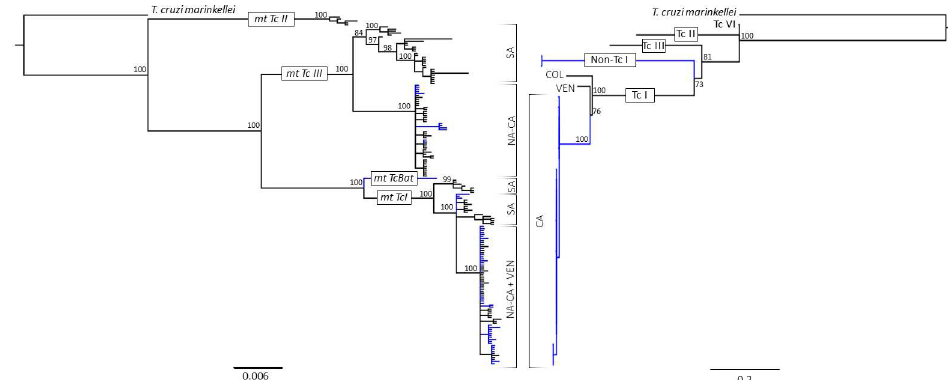
Fig 2. Trypanosoma cruzi phylogenetic analysis based on mitochondrial DNA and nuclear single copy genes. Left: Mitochondrial phylogeny based on COII-ND1 genes, inferred under the HKY model from 866 nucleotides from over 210 samples total (GenBank and study samples). Right: Phylogenomic analysis based on conserved nuclear single copy genes, inferred under the General Time Reversible model (GTR) from 819 SNPs from 35 samples total. Branch support is represented as percentages next to each clade. Blue branches represent T . cruzi sequences from this study; black branches represent T . cruzi GenBank sequences. GenBank accession numbers for the reference genomes used for the phylogenomic tree on the right: T . marinkellei (outgroup), Tc I (ADWP02 and AODP01), Tc II (ANOX01), Tc III (OGCJ01) and Tc VI (AAHK01). Abbreviations: North America (NA), Central America (CA), South America (SA), Venezuela (VEN), Colombia